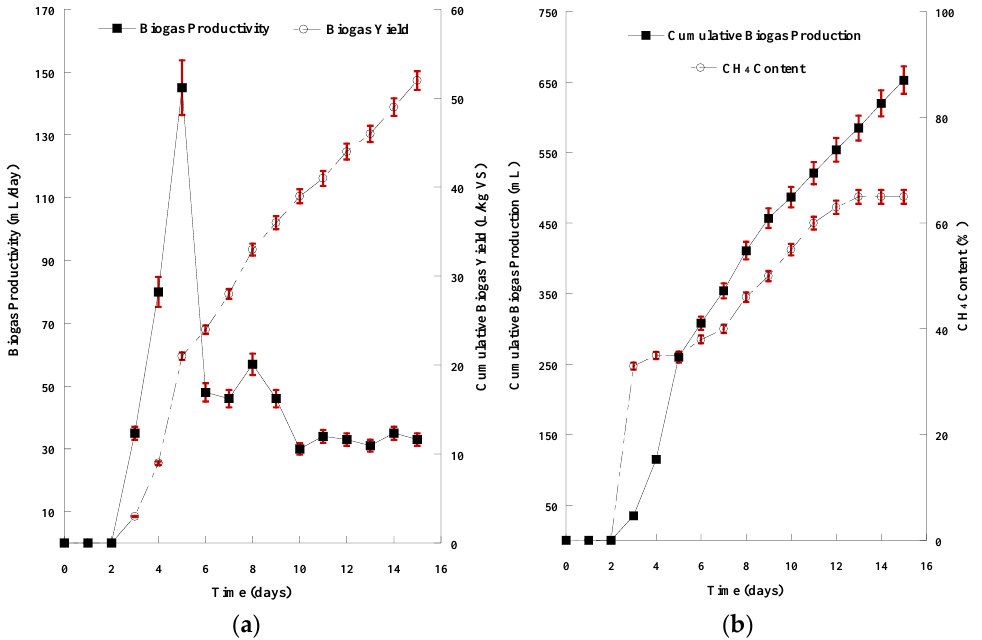
Figure 4. ( a ) Graphical representation of biogas productivity (mL/d) and biogas yield (L/kg VS) resulted from the anaerobic digestion of SMS acidic hydrolysate; ( b ) Graphical representation of cumulative biogas production (mL) and CH 4 content of the biogas resulted from the anaerobic digestion of SMS acidic hydrolysate. The presented results are the mean of two independent digestions.